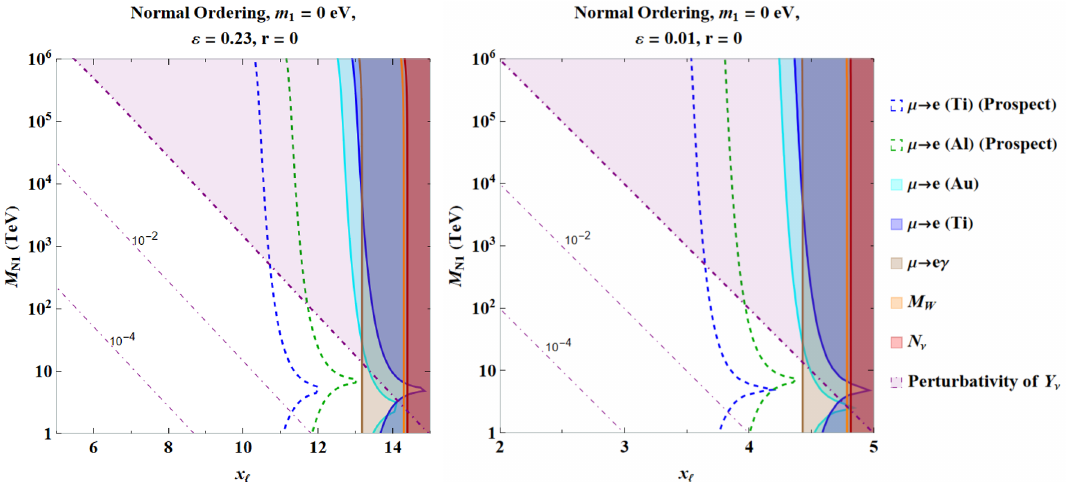
Figure 1 . Parameter space of the mass of the lightest exotic neutral lepton M N 1 as a function of the PQ charge x ‘ . Lines and colours are explained in the legend and in the text. Both plots refer to the NO case with a massless lightest active neutrino m 1 = 0 , assuming φ i = 0 , i.e. p r ≡ φ 2 + φ 2 + φ 2 = 0 . The plot in the left (right) holds for ε = 0 . 23 ( ε = 0 . 01 1 2 3